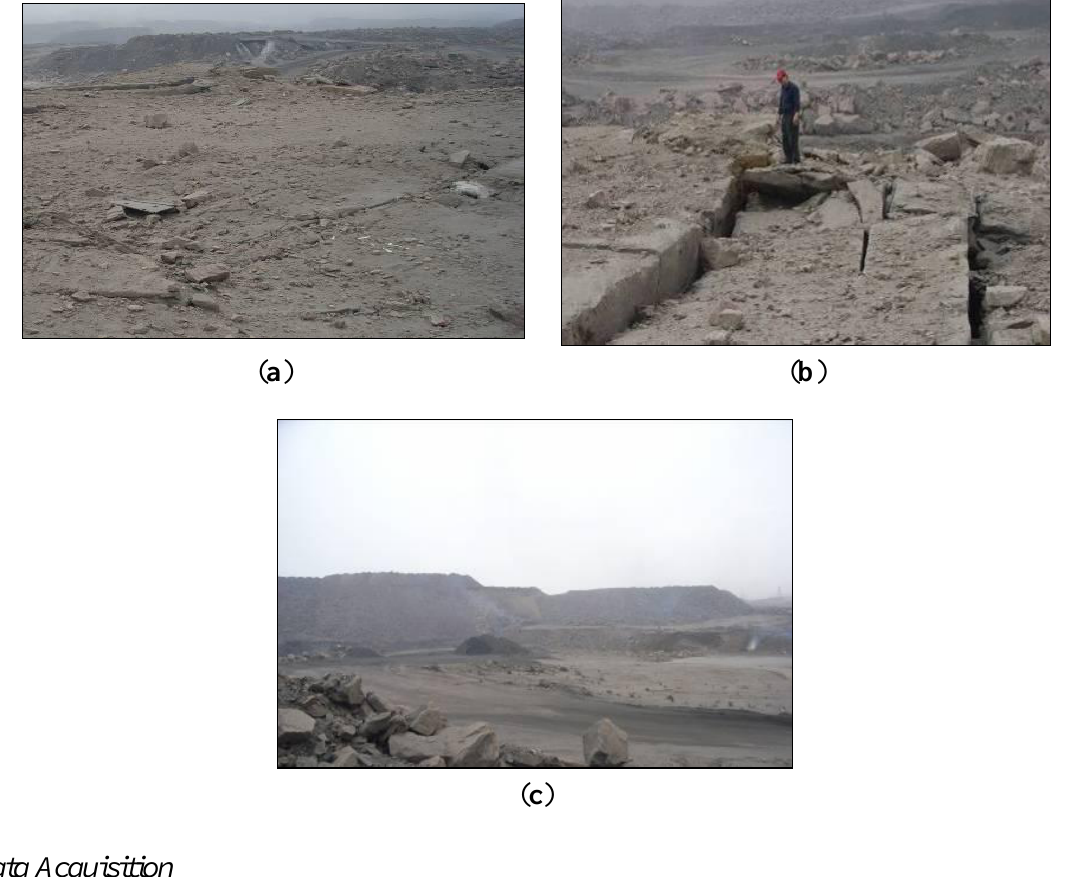
Figure 2. Field pictures of different types of land subsidence in the Wuda coalfield. ( a ) A slow trough-like land subsidence related to underground coal fires happened in coal fire areas. ( b ) A sudden surficial cracks related to underground coal fires happened in coal fire areas. ( c ) Land subsidence caused by underground mining activities in coal mine